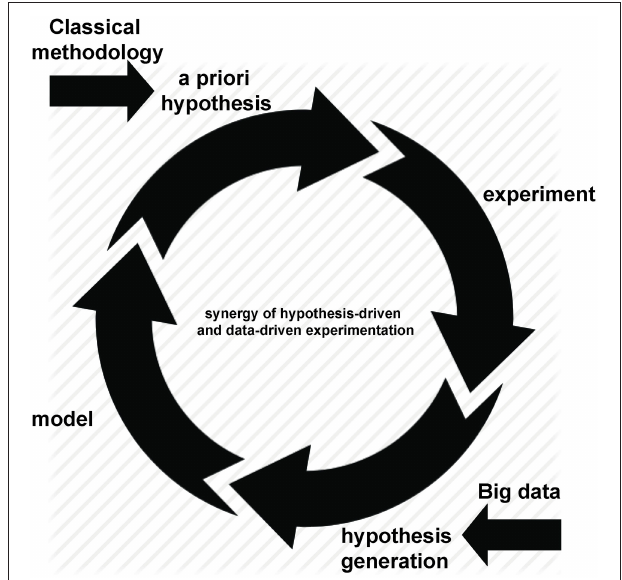
FIGURE 1 | The synergistic cycle of hypothesis-driven and data-driven